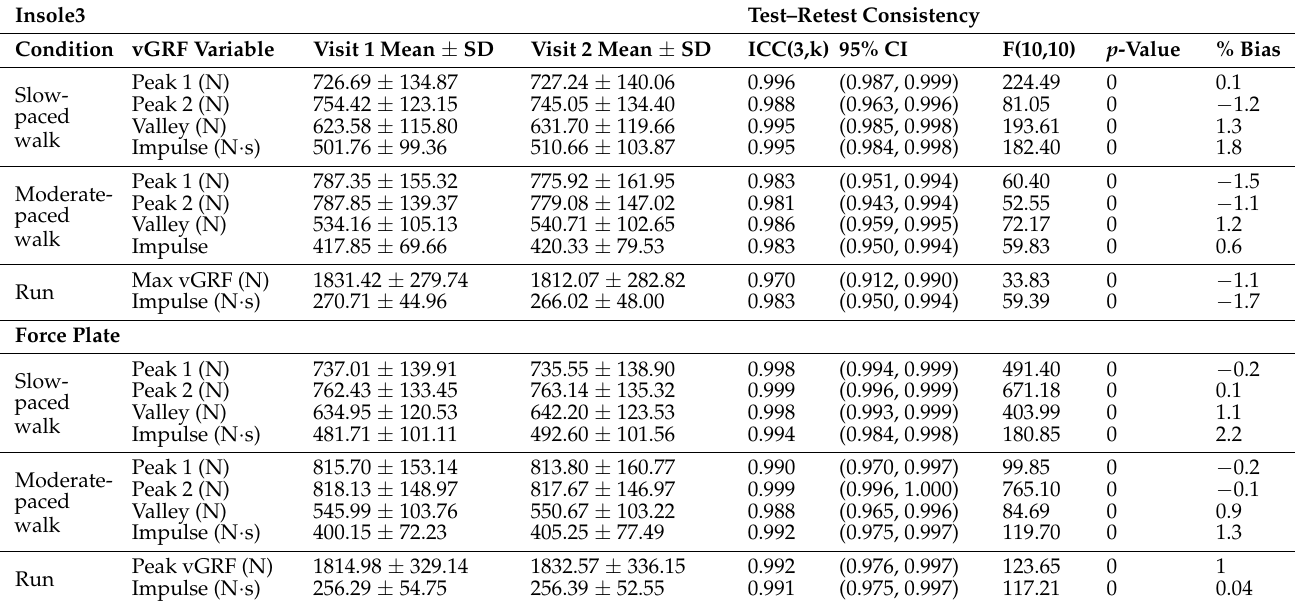
Table 3. Test–retest reliability between visits for each vertical ground reaction force (vGRF) variable during slow walking, moderate-paced walking, and running. Consistency between Visit 1 and Visit 2 is reported for two-way mixed effects and multiple measurements; Visit 1 and Visit 2 means were compared for peak and valley forces (N) and impulses (N·s). ICC = Intraclass correlation coefficient; CI = Confidence interval.